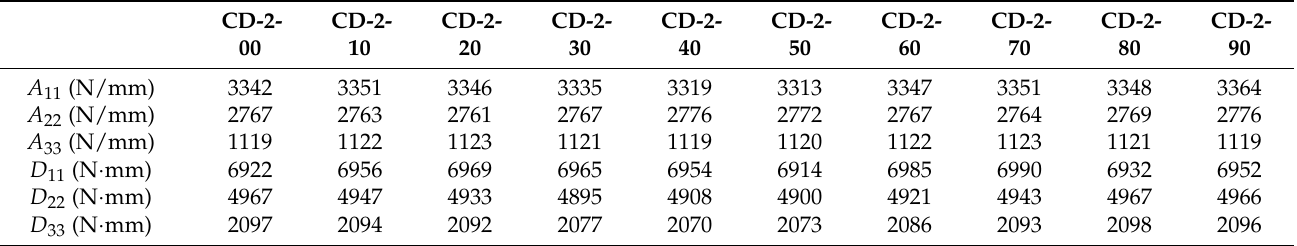
Table 9. The selected stiffnesses with 2% imperfections of compression in the CD shape and with different